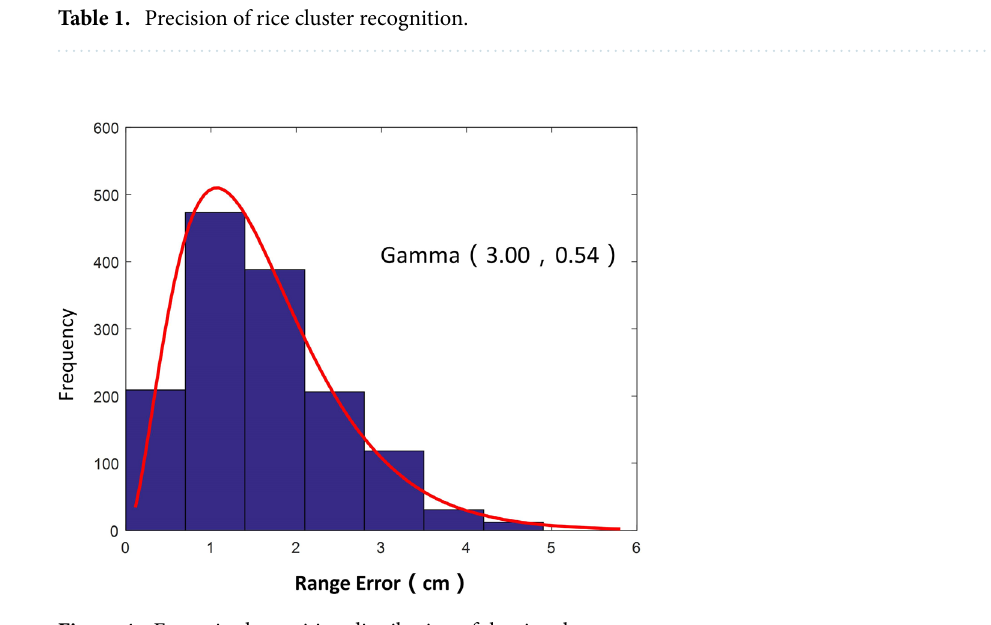
Figure 4. Errors in the position distribution of the rice